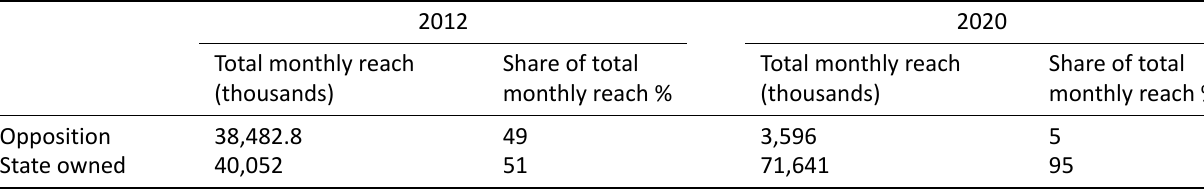
Table 1. Total monthly reach and share of opposition and state‐controlled online